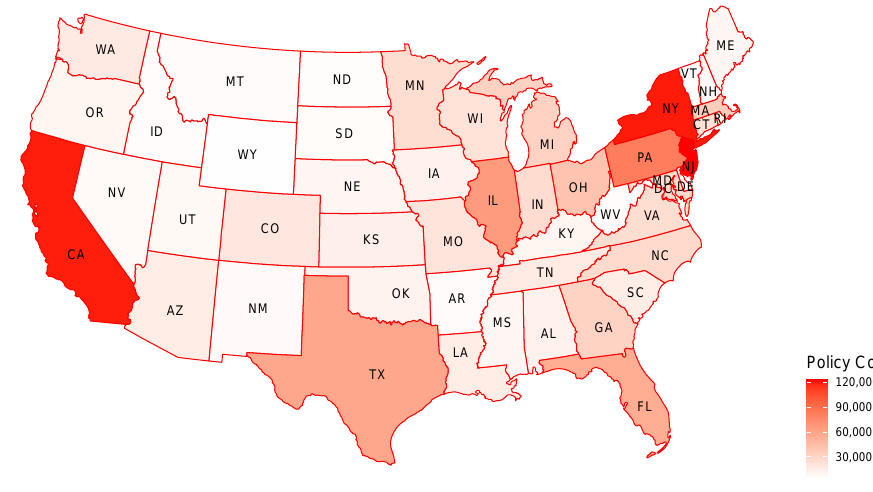
Figure 1. U.S heatmap of policy